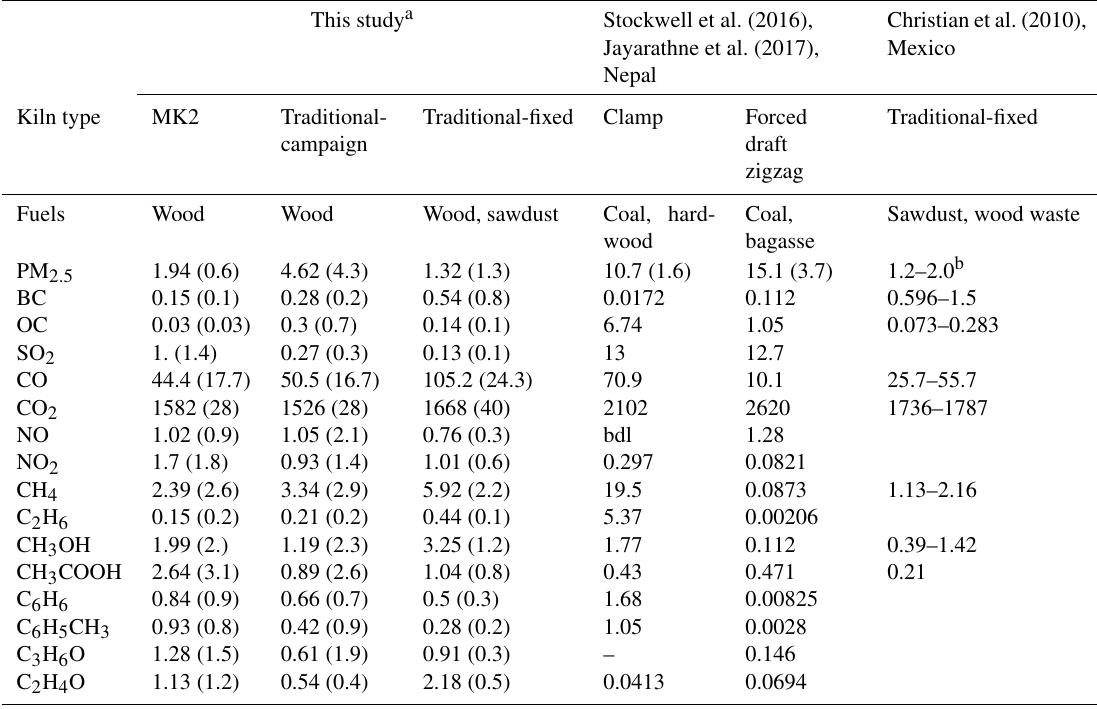
Table 4. Comparison of fuel-based emission factors (g ( kg fuel ) − 1 ) measured in this study with other studies. This study